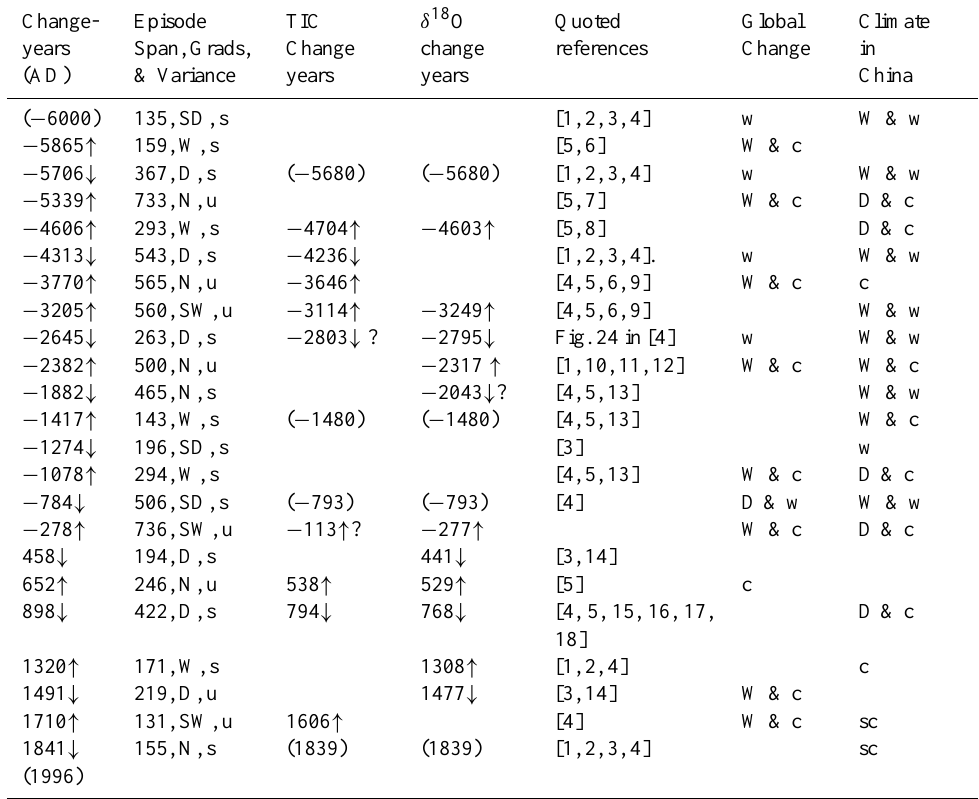
Table 1. Change points and Wet /Normal/Dry episodes in the Precipitation reconstruction series, and sources of collaborative evidence (TIC, δ 18 O, paleoclimate references) for each